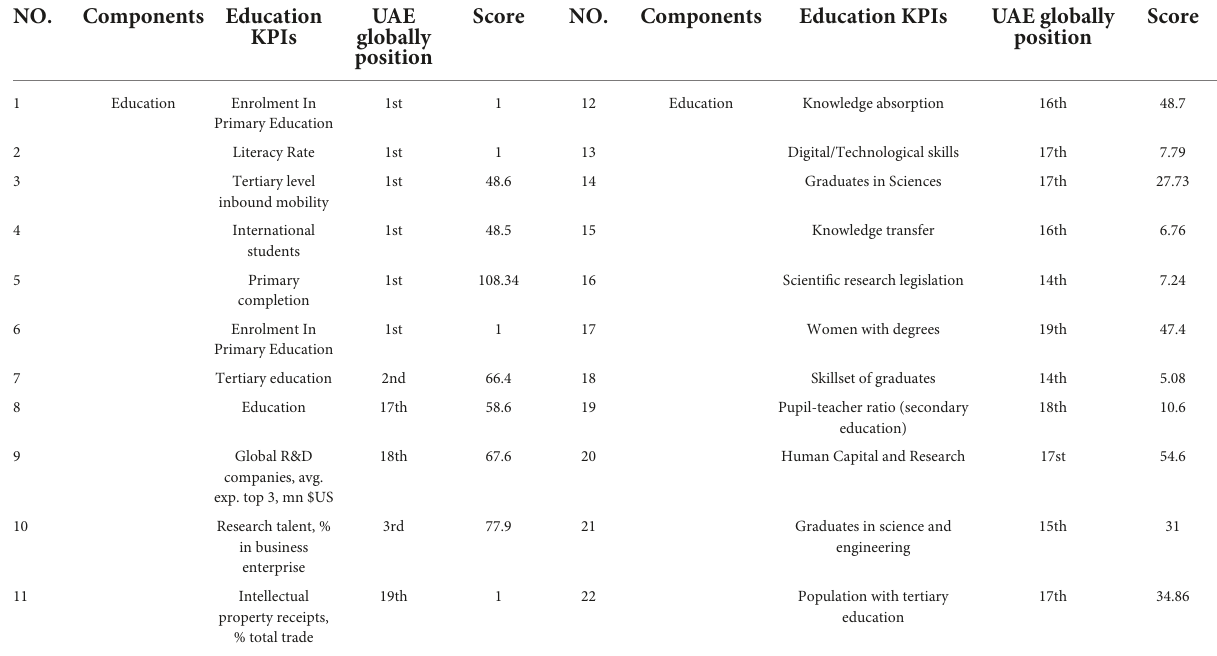
TABLE 5 Global innovation index Vs